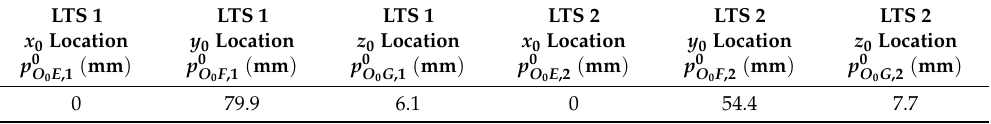
Table 1. Installation geometrical information of the twin